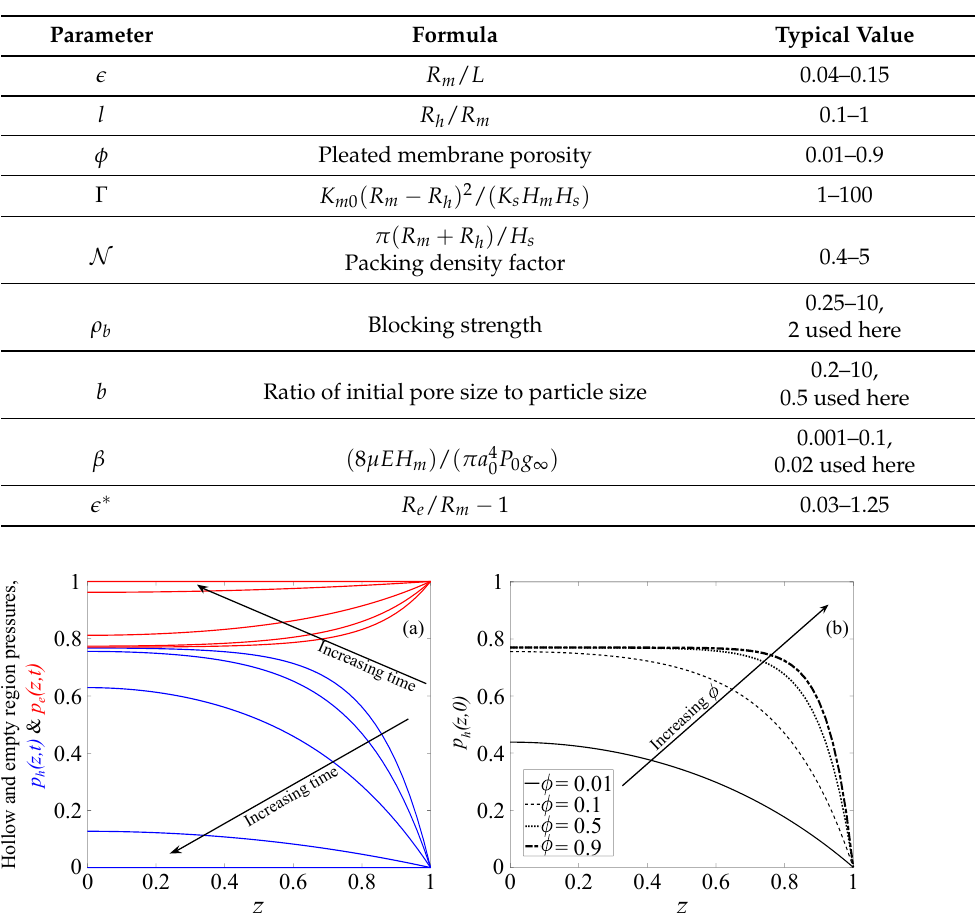
Table 2. Dimensionless parameters and approximate values [11,31,40].